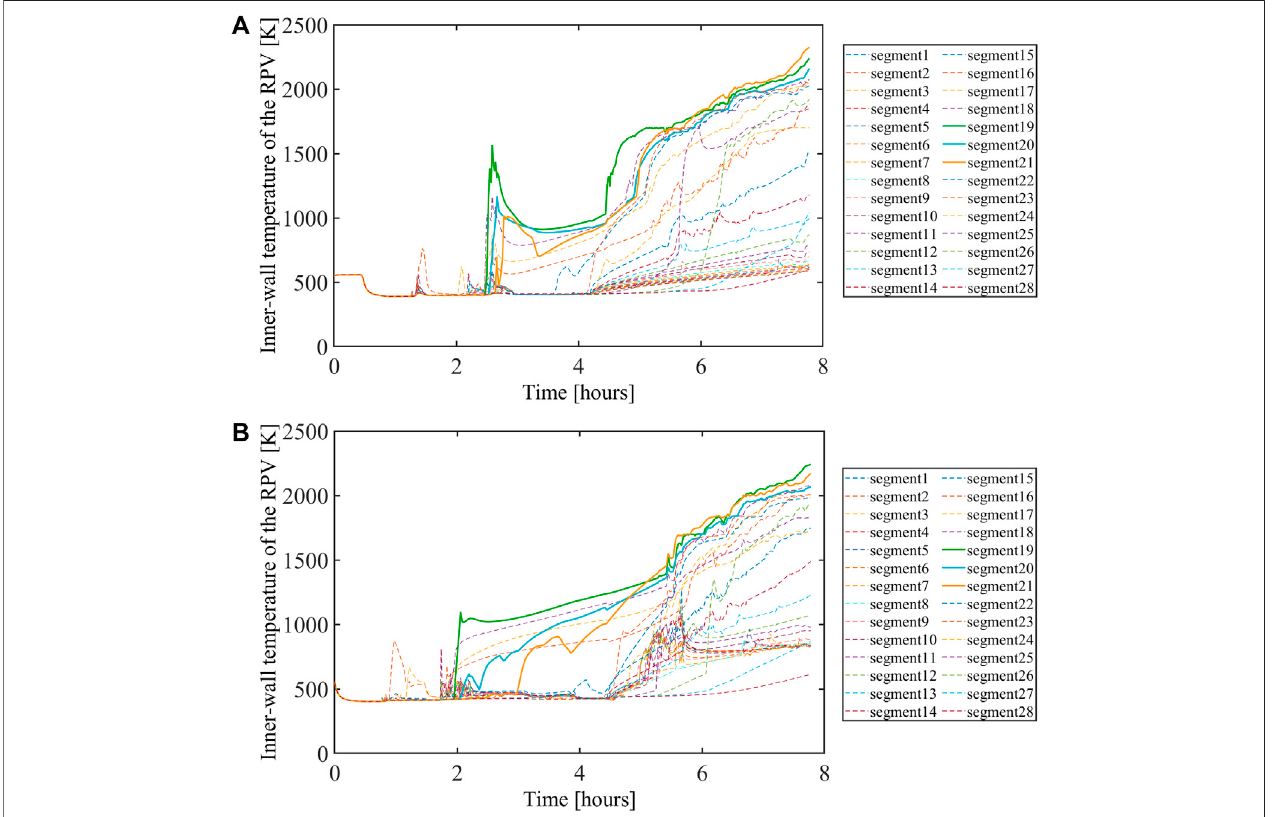
FIGURE 5 | Evolution of (A) the inner-wall temperature of the RPV in the SBO case and (B) the inner-wall temperature of the RPV in the SBO + LOCA case.